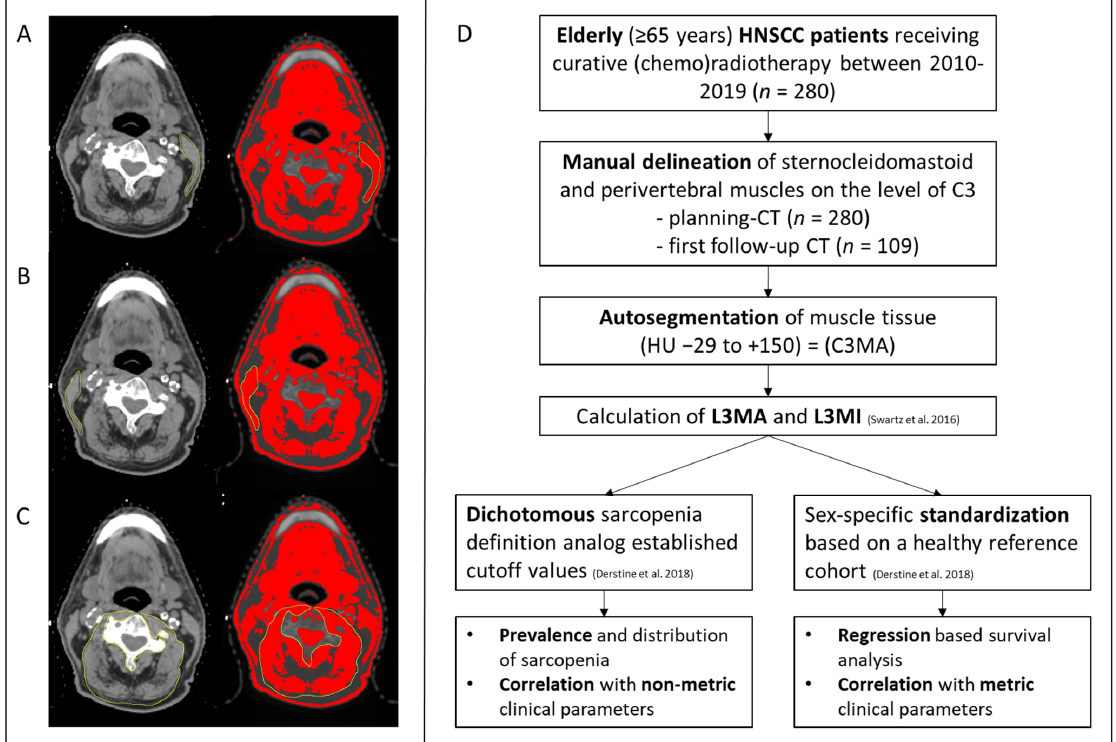
Figure 1. Methodology of skeletal muscle mass assessment for sarcopenia determination in HNSCC patients. Manual delineation (thin yellow contour) of the left sternocleidomastoid muscle ( A ), right sternocleidomastoid muscle ( B ) and paravertebral muscles ( C ) at the level of C3 with Hounsfield- Unit guided autosegmentation of muscle tissue (red area). ( D )Flow diagram of data acquisition and data processing. HNSCC, head and neck squamous cell carcinoma; C3, third cervical vertebra; CT, computed tomography; HU, Hounsfiled-Units; C3MA, cross-sectional skeletal muscle area at the third cervical vertebra; L3MA, cross-sectional skeletal muscle area at the third lumbar vertebra; L3MI, skeletal muscle index at the third lumbar vertebra